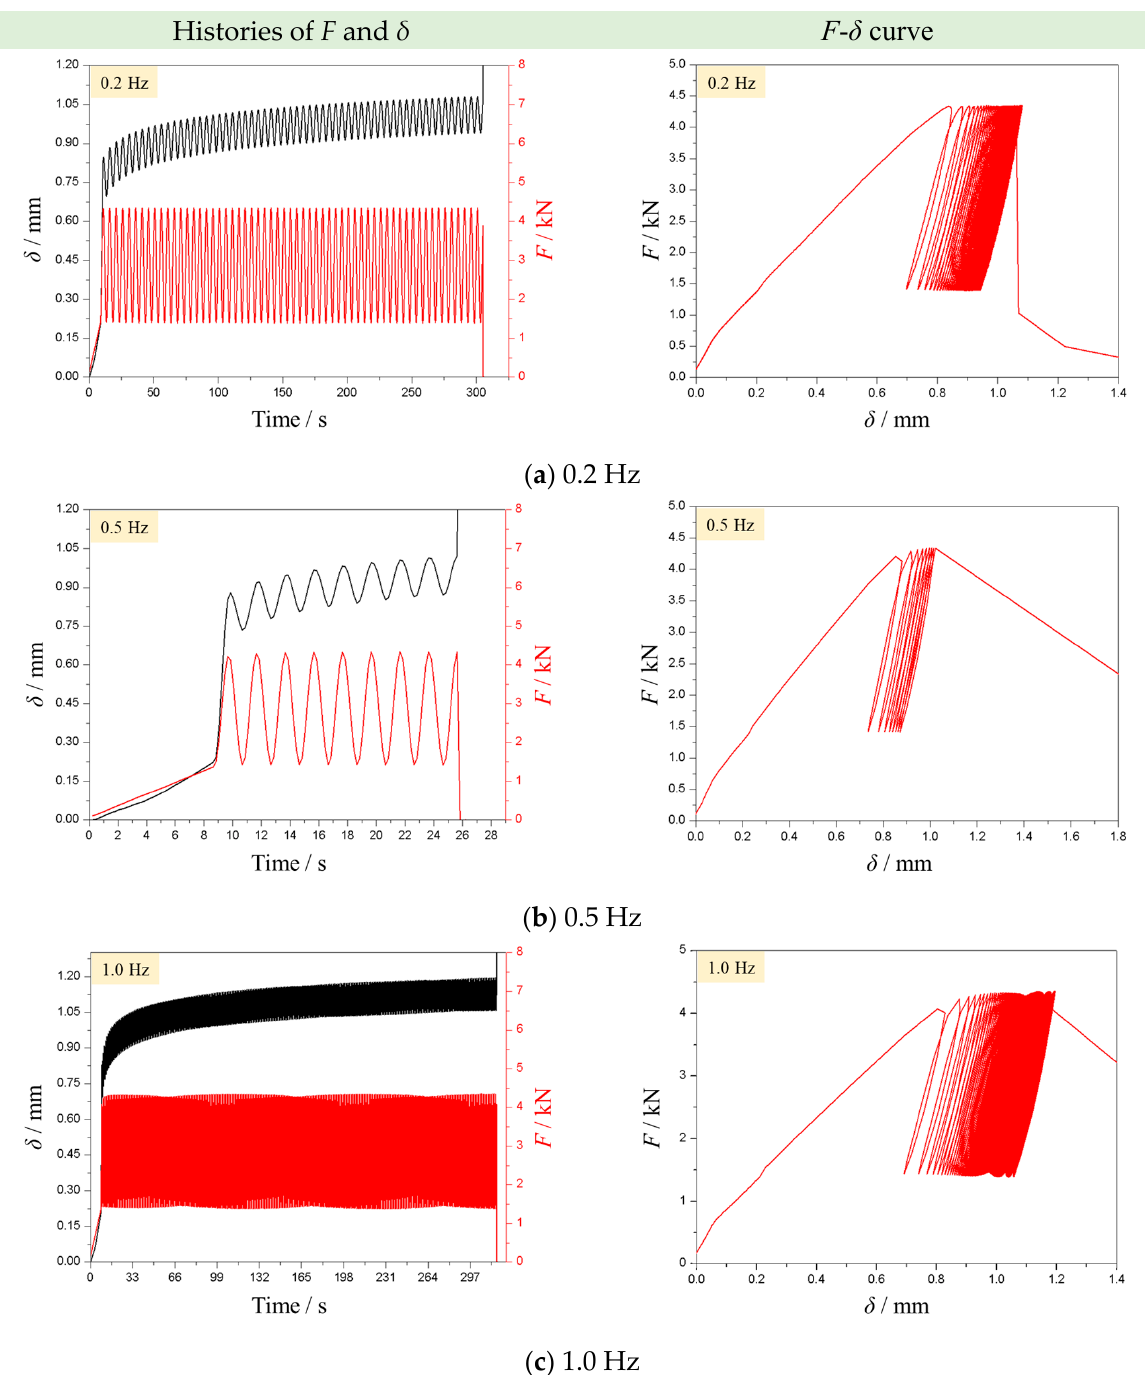
Figure 6. Typical curves of load and indentation depth in CPL tests with the frequencies of ( a ) 0.2 Hz, ( b ) 0.5 Hz, and ( c ) 1.0 Hz (the left column shows the histories of F and δ , and the right column shows the F - δ curves).